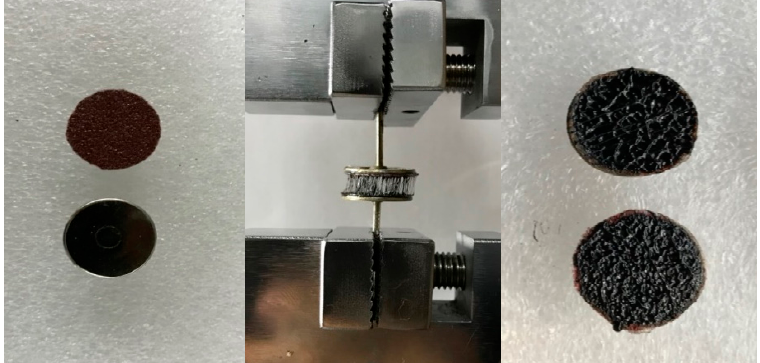
Figure 1. Flat head steel tacks ( left ), test setup ( middle ) and the fractured surfaces after testing ( right ).